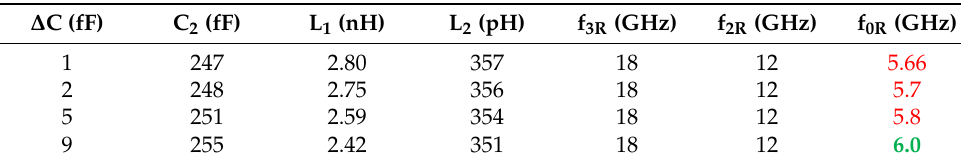
Table 1. Comparison of results extracted by the iterative